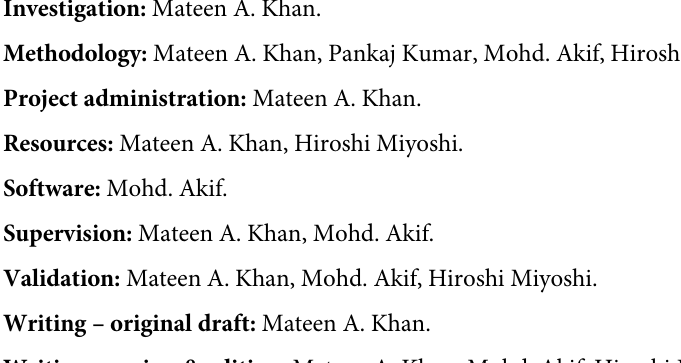
S1 Table. Interaction interface